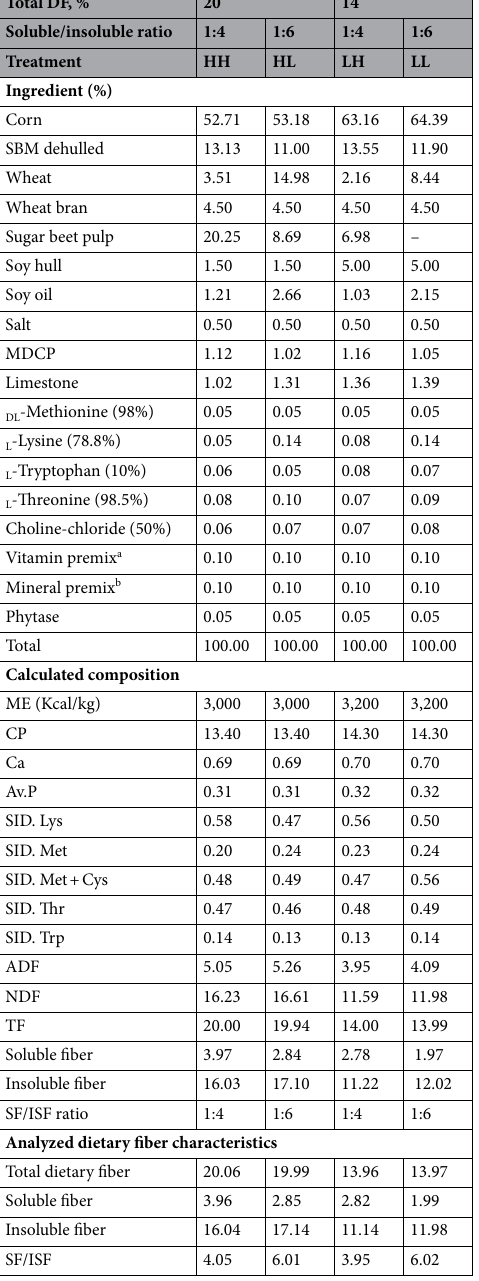
Table 6. Formula, chemical composition and analyzed dietary fiber characteristics of experimental basal diets (as-fed basis). DF dietary fiber, SF soluble fiber, ISF insoluble fiber, ADF acid detergent fiber, NDF neutral detergent fiber, TF total fiber. a Supplied per kilogram of vitamin premix for 14% DF diets: 12,000,000